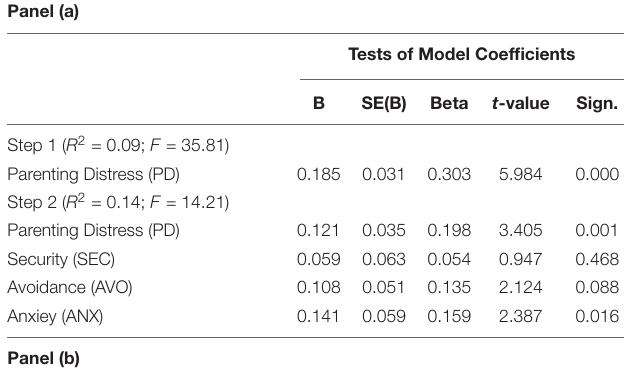
TABLE 5 | Summary of hierarchical regression analysis for parenting stress and attachment styles to predict children’s regulatory functions. Panel (a)